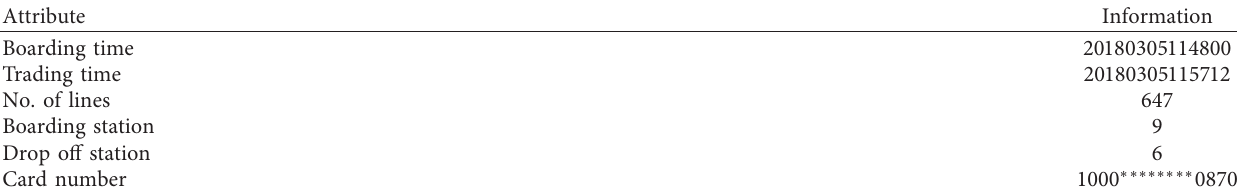
Table 3: Information structure of bus IC Card.